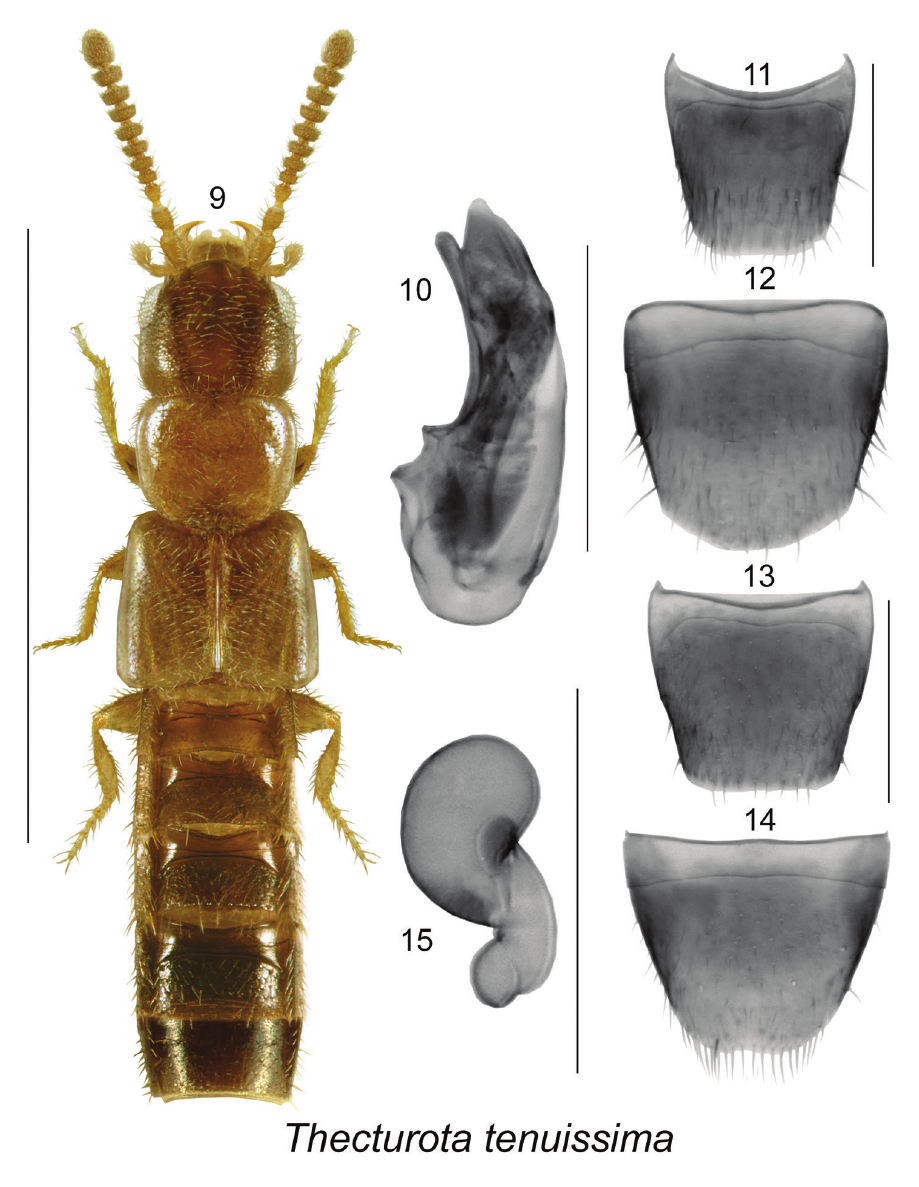
Figures 9–16. Thecturota tenuissima Casey: 9 habitus in dorsal view 10 median lobe of aedeagus in lat- eral and dorsal view 11 male tergite VIII 12 male sternite VIII 13 female tergite VIII 14 female sternite VIII 15 spermatheca. Scale bars: 1 mm for habitus; 0.2 mm for remaining